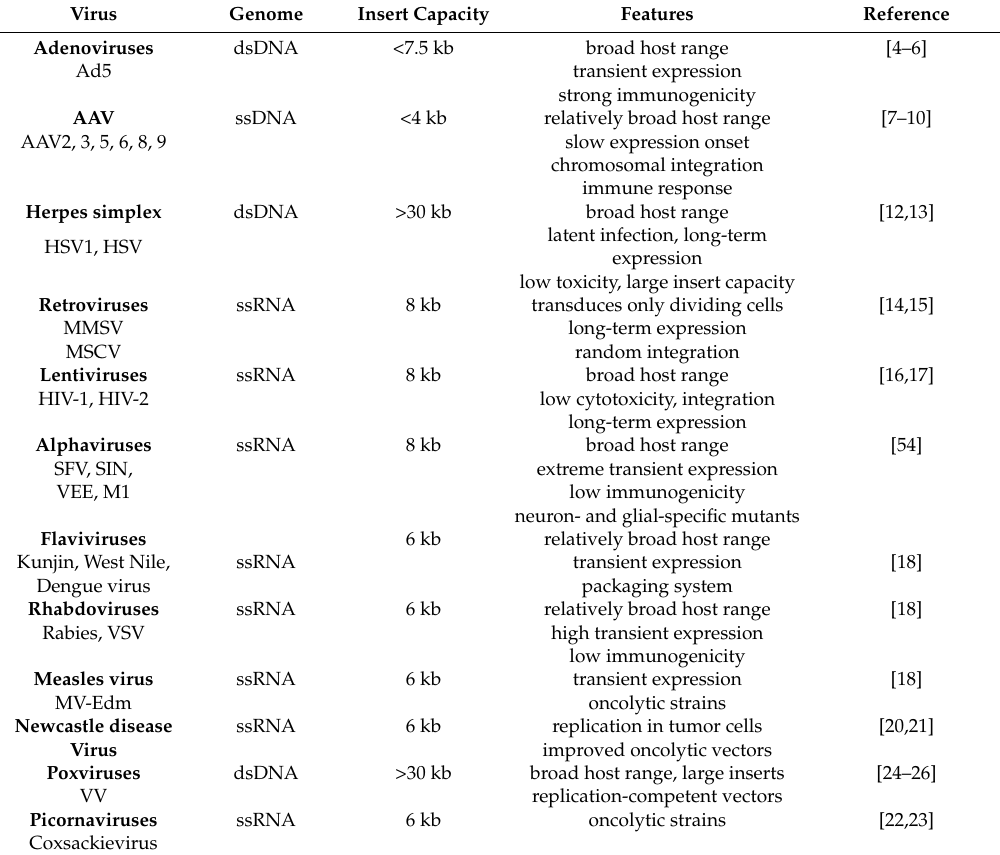
Table 1. Examples of viral vectors applied for gene